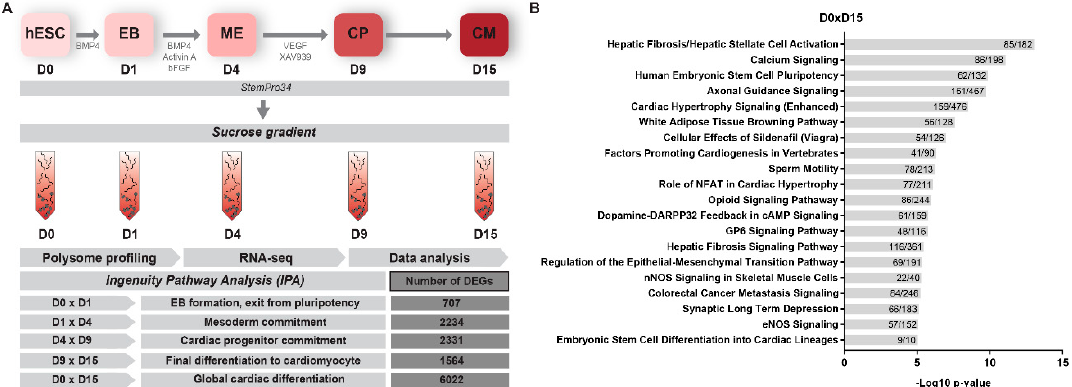
Figure 1. In vitro cardiac differentiation and data analysis. ( A ) The experimental procedure consisted of human embryonic stem cell (hESC) cardiac differentiation, polysome sample collection for RNA-seq and data analysis. hESCs, human embryonic stem cells. EB, embryoid body. ME, cardiac mesoderm. CP, cardiac progenitors. CM, cardiomyocyte. ( B ) Top 20 IPA canonical pathways enriched in the D0 × D15 transition. The ratios between the number of differentially expressed genes (DEGs) found and the total number of genes of each canonical pathway are shown inside the bars.